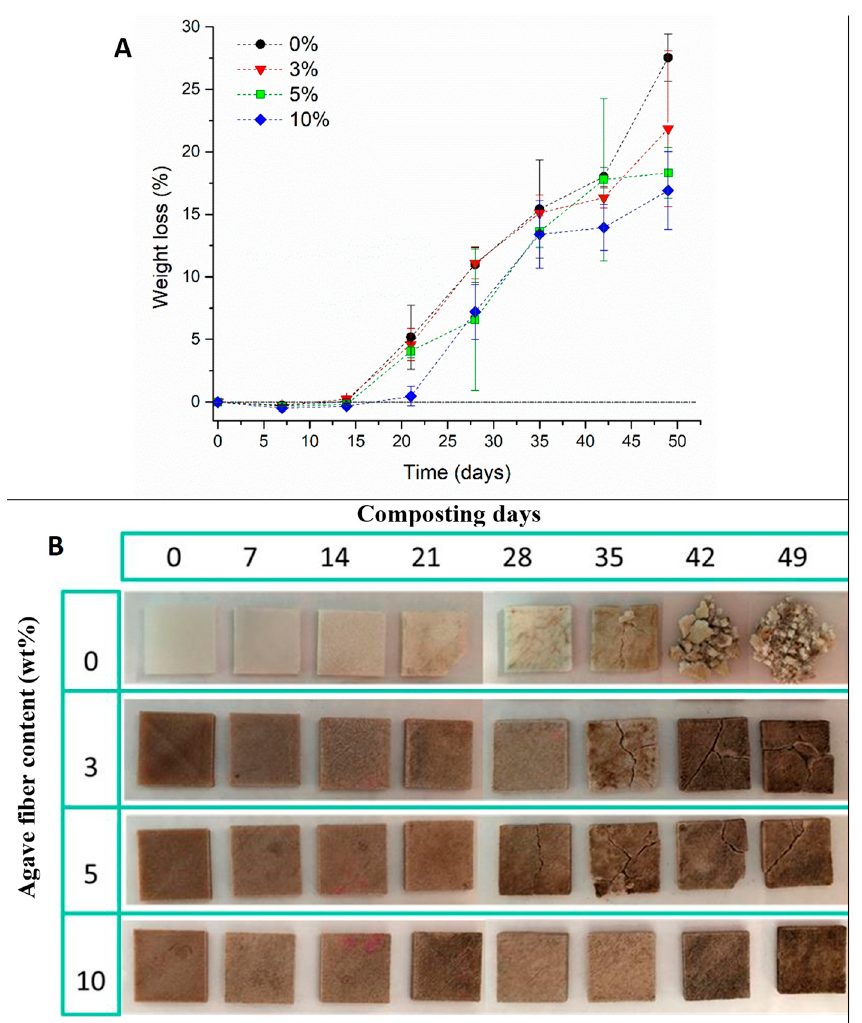
Figure 7. ( A ) Percentage weight losses of agave fiber/PLA printed biocomposites under simulated composting conditions and ( B ) photographs of agave fiber/PLA pieces after being composted.